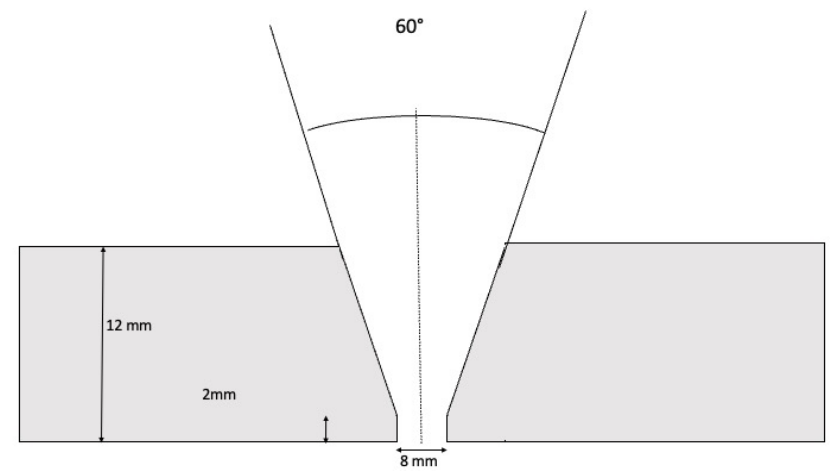
Figure 1. Scheme of a weld specimen.